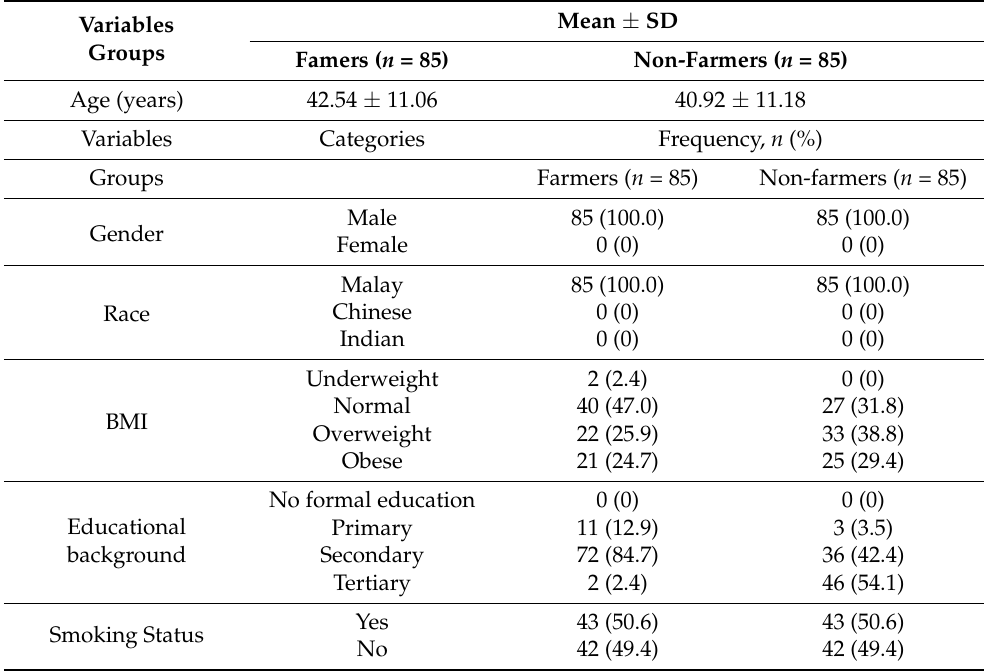
Table 2. Socio-demographic information of the respondents.